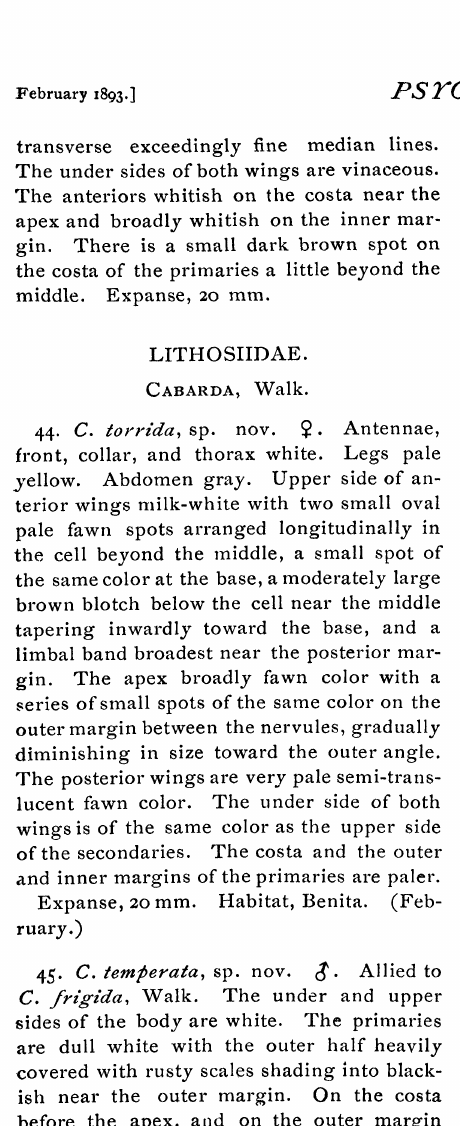
sides of the body are white. The primaries are dull white with the outer half heavily covered with rusty scales shading into black- ish near the outer margin. On the costa before the apex, a,d on the outer margin just below the apex, this ferruginous tract is indented by two subtriangular pure white spots. The posterior wings are grayish, darkest near the outer margin, and the fringes of both primaries and secondaries are whitish. On the under side, both wings are whitish, the primaries being clouded to pale